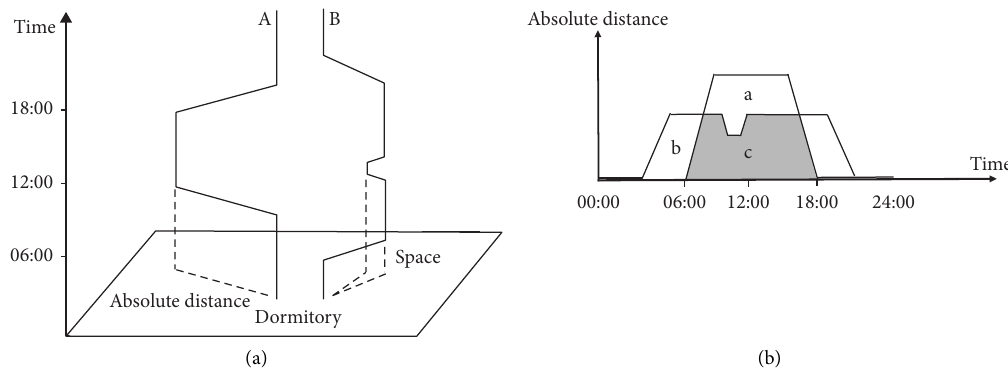
Figure 11: Similarity measurement method based on spatiotemporal path. (a) Three-dimensional spatiotemporal path. (b) Two-di- mensional time-distance coordinate system diagram.